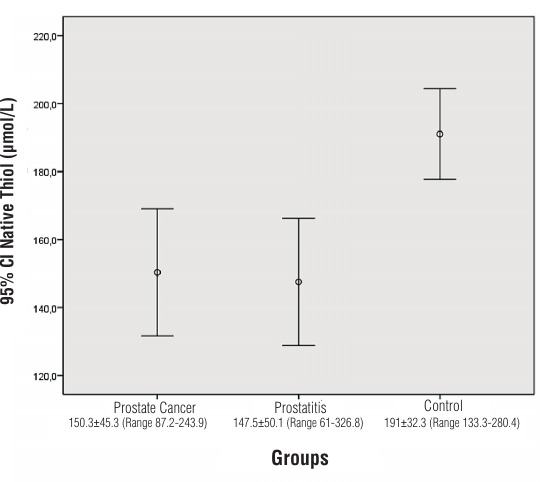
Figure 1 - Comparison of native thiol levels. Figure 2 - Comparison of total thiol